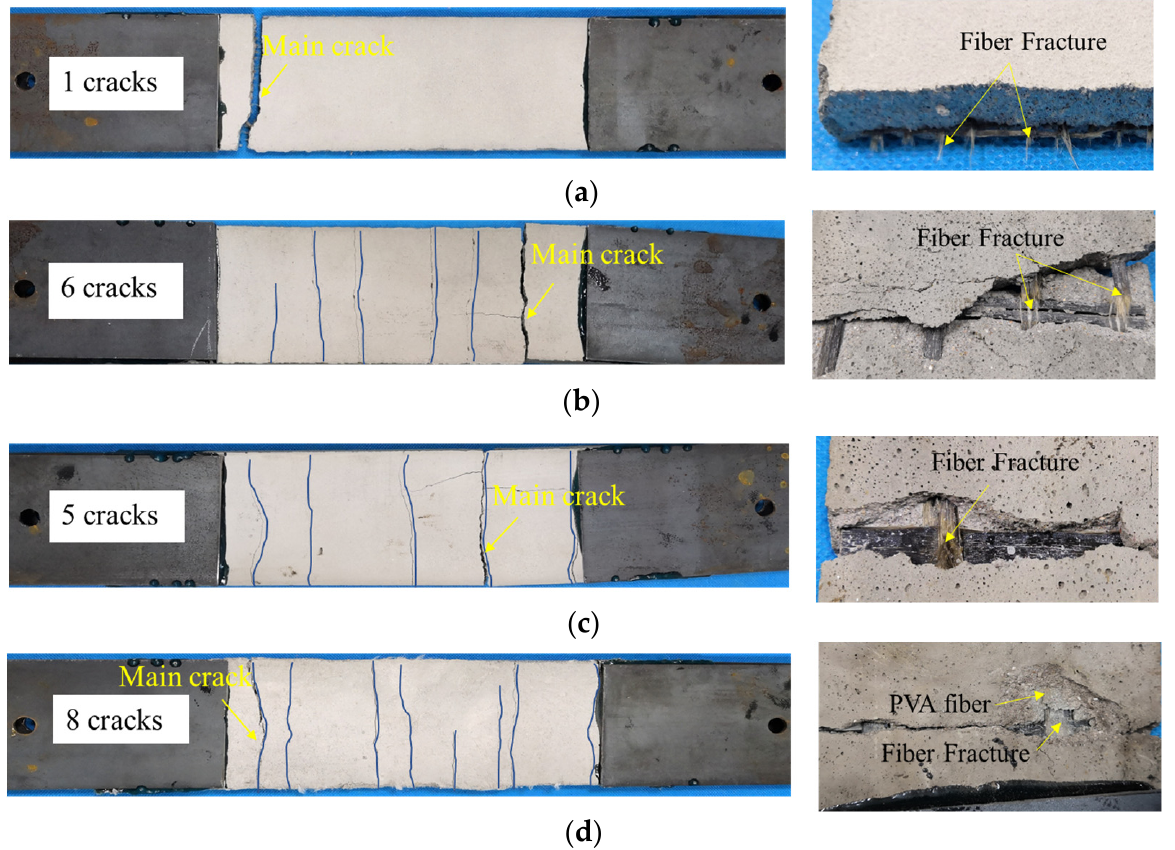
Figure 6. Failure and cracking modes of the BGRM before exposure to elevated temperature: ( a ) BT5-CT; ( b ) BT25-CT; ( c ) BG50-CT; ( d ) BG50F-CT.